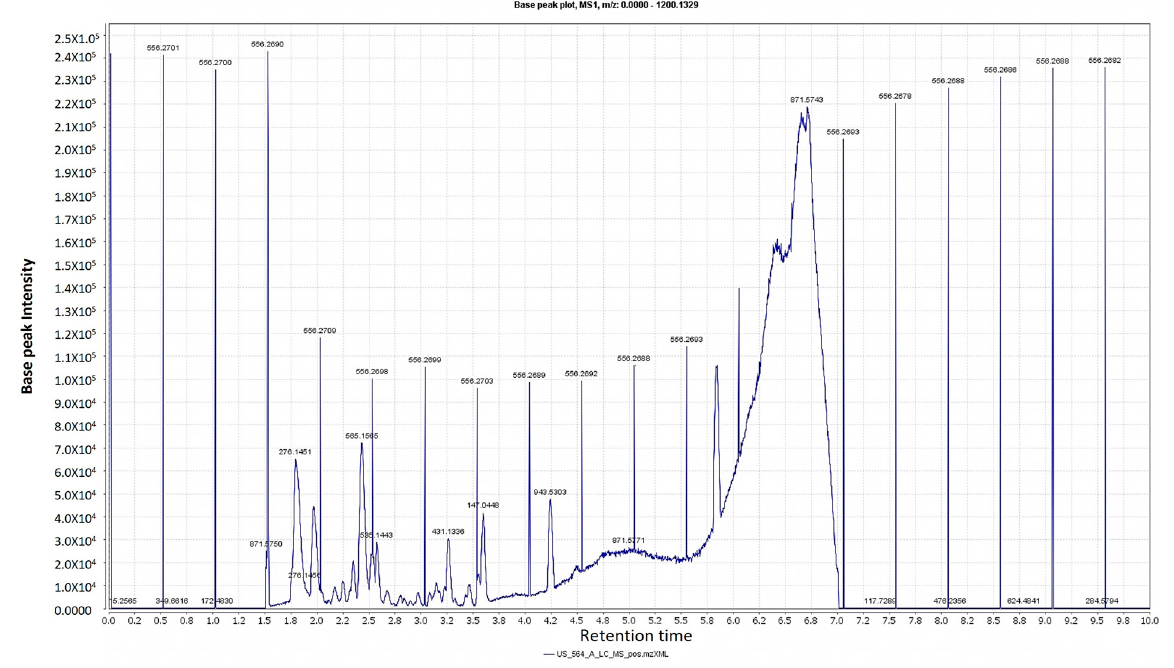
Figure 1. LC-HRESIMS chromatogram of the dereplicated metabolites of Trigonella stellata (positive). Table 1. The LC-HRESIMS dereplication results of Trigonella stellat a methanolic extract.